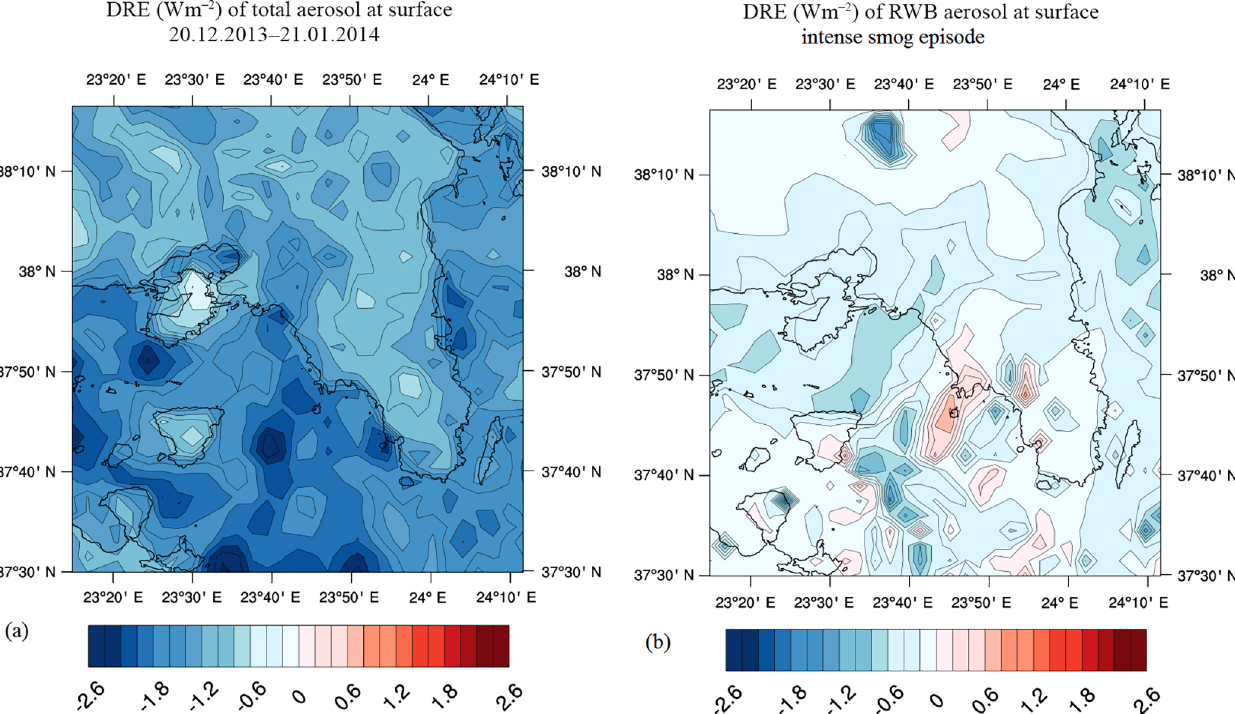
Figure 9. The spatial distribution of the direct radiative effect (Wm − 2 ) of the aerosol load at the ground level, over the extended area of Athens, during (a) a winter month (20 December 2013–21 January 2014), taking into account the total aerosol load (mean monthly difference between case 2 and case 4); and (b) the RWB smog episode (4–5 January 2014), isolating the RWB aerosol load (mean daily difference between case 2 and case